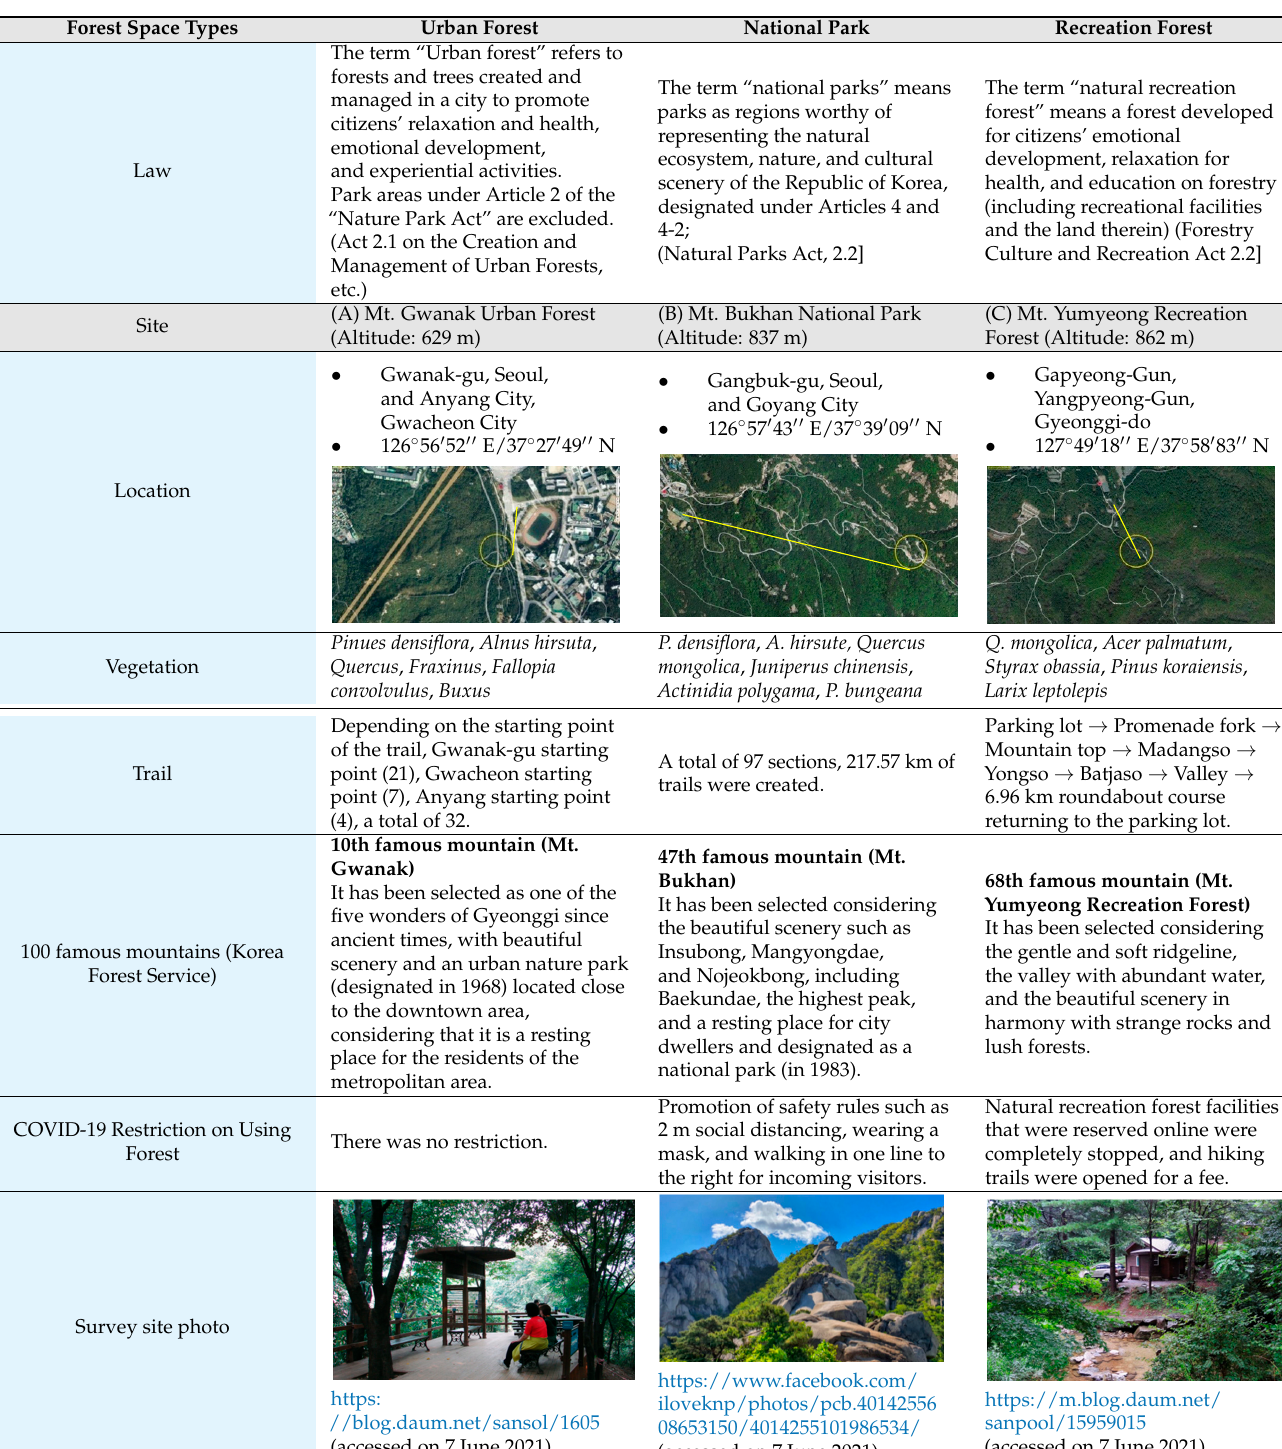
Figure 1. Research sites located in the suburbs of Seoul. ( A ) Mt. Gwanak Urban Forest; ( B ) Mt. Bukhan National Park; ( C ) Mt. Yumyeong Recreation Forest (https://map.forest.go.kr/forest/#/) (accessed on 7 June 2021). Table 1. Study